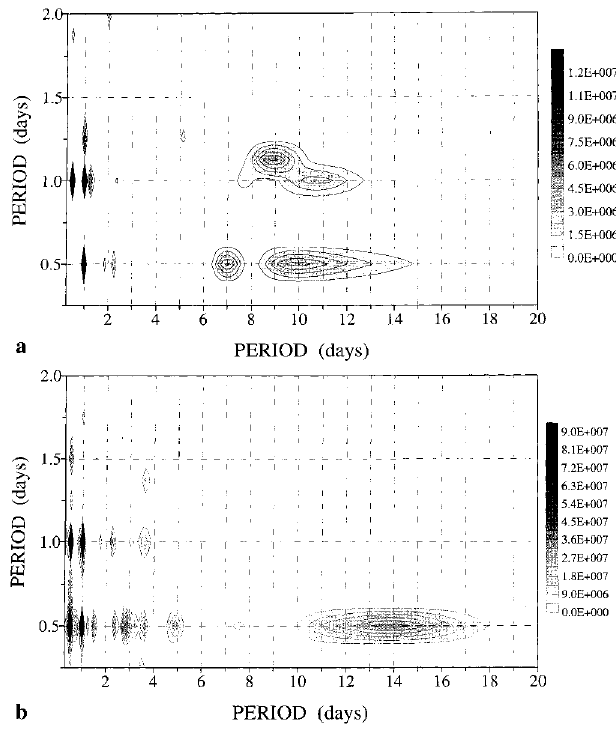
Fig. 5a, b. The contour plot of the magnitude squared bispectrum in the periodic interval 0.25–20 days for: a the zonal wind, and b the meridional wind, during the interval 21 November 1991–16